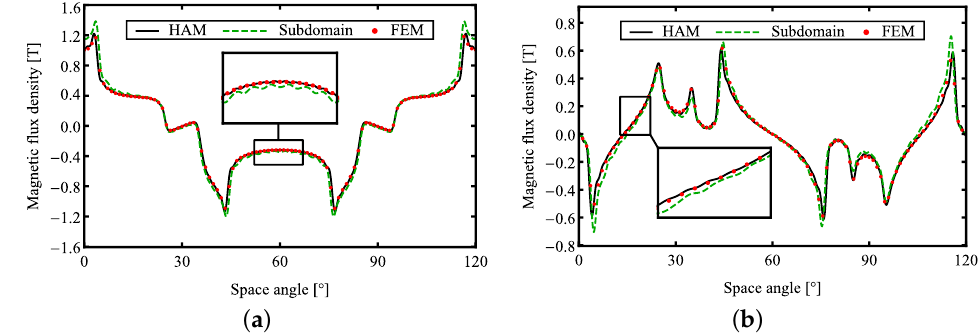
Figure 15. Comparison of the flux density at the middle of the air gap of Machine II in open-circuit condition: ( a ) radial component; ( b ) circumferential component.